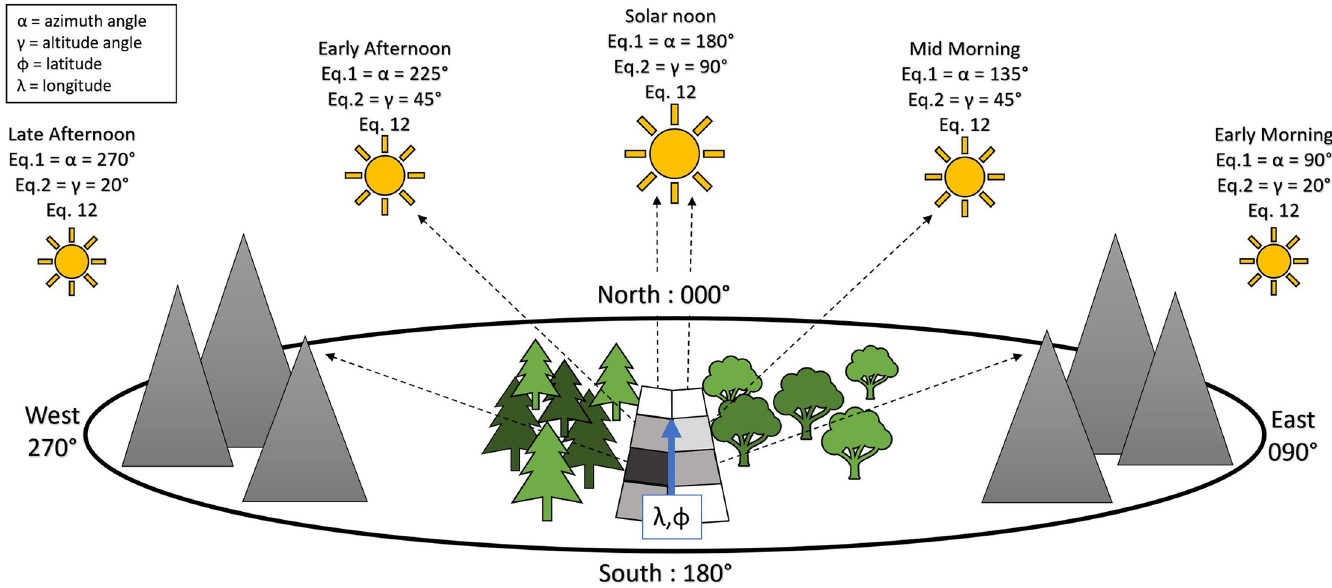
Fig 1. Summary of Penumbra model solar energy tracking. Penumbra’s approach to shade modeling for both object and topographic shadowing. A representative set of solar angles are presented, where the cell shade level corresponds to the arrow associated with that cell. Landscape and objects the arrow intercepts dictates the shadow effect upon the cell. Equation numbers correspond to equations described under the Processing